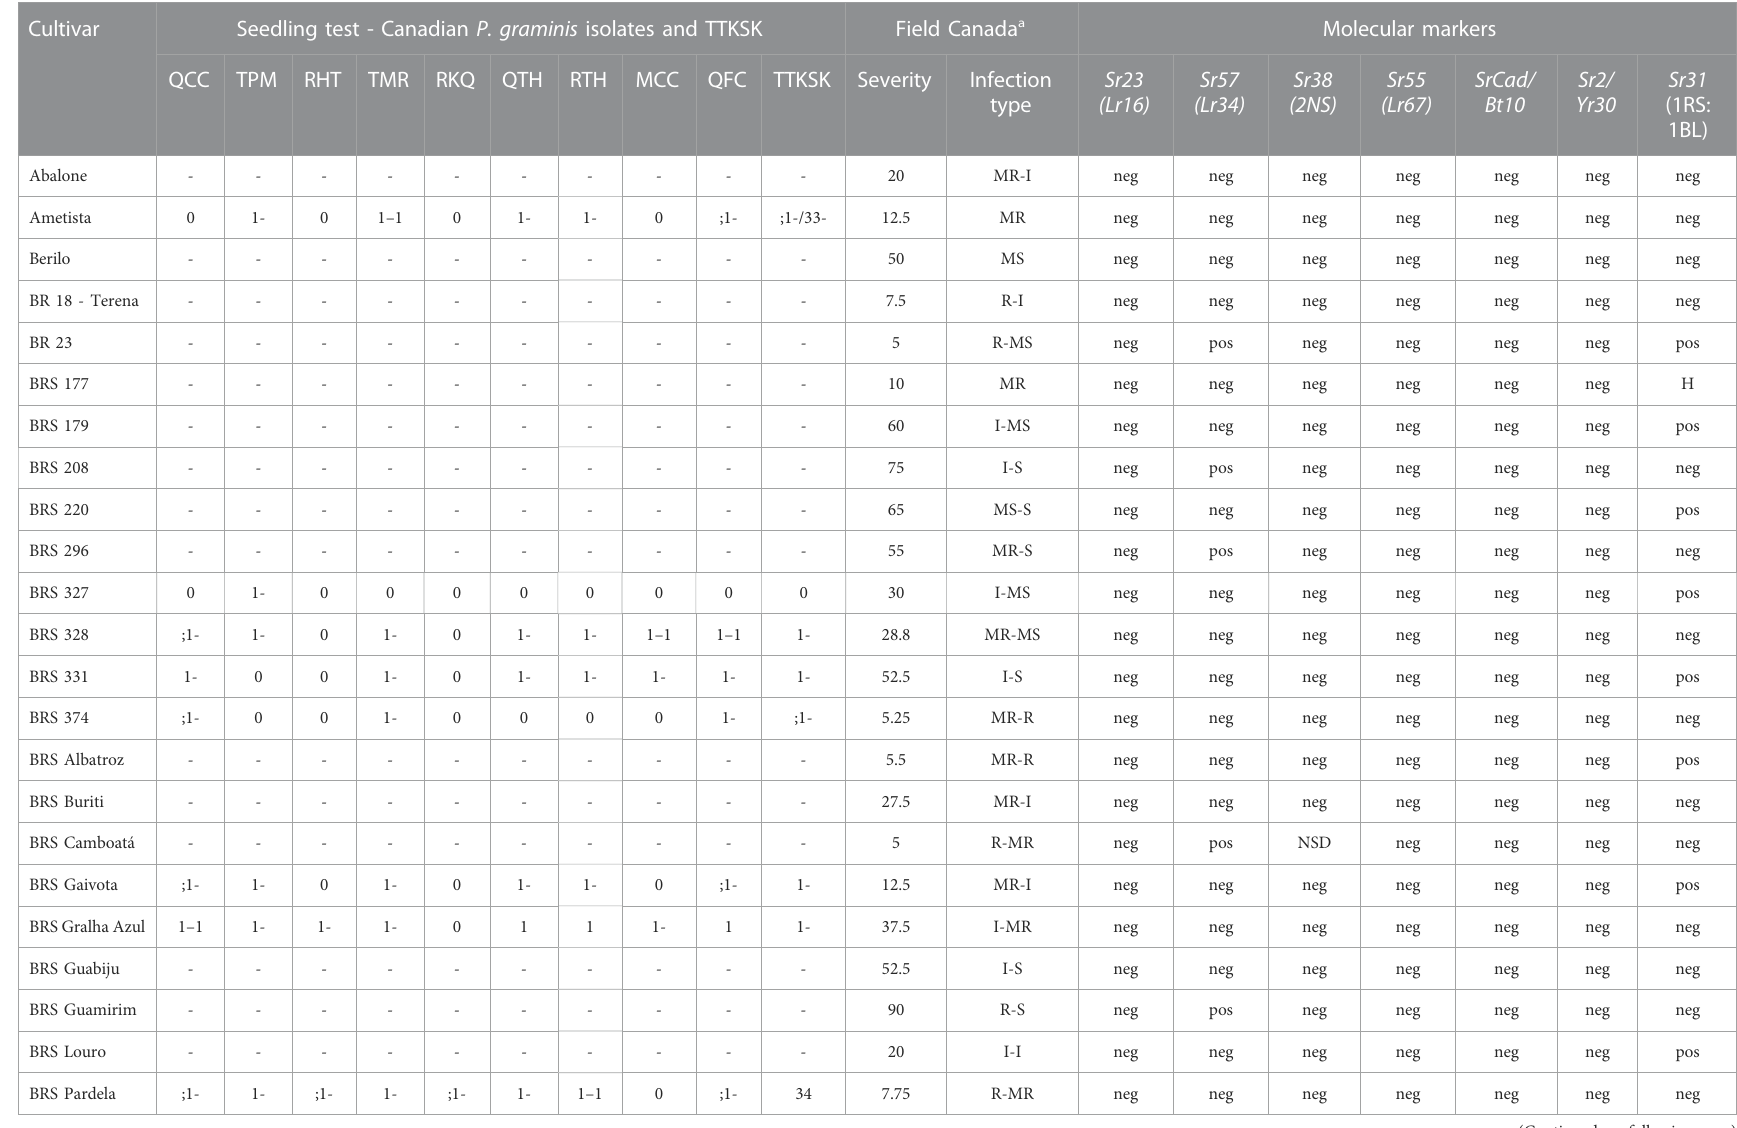
TABLE 4Characterizationof the Brazilian collections tostem rust( Pucciniagraminis ). Reactionatseedling stageof Brazilian wheat cultivars toCanadian stem rustisolates andTTKSK,and fi eld datainCanada. Prediction ofthe resistance genes in the collection by genotypage of genes/loci related with stem rust resistance. Pos: positive allele, presence of the resistant allele; neg: negative, presence of the susceptible allele; H: heterozygosity in